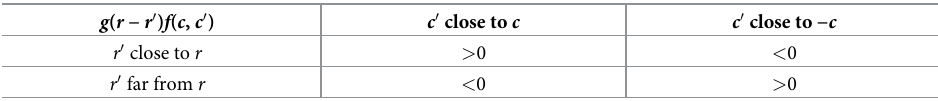
Table 2. Sign of the connectivity kernel ω